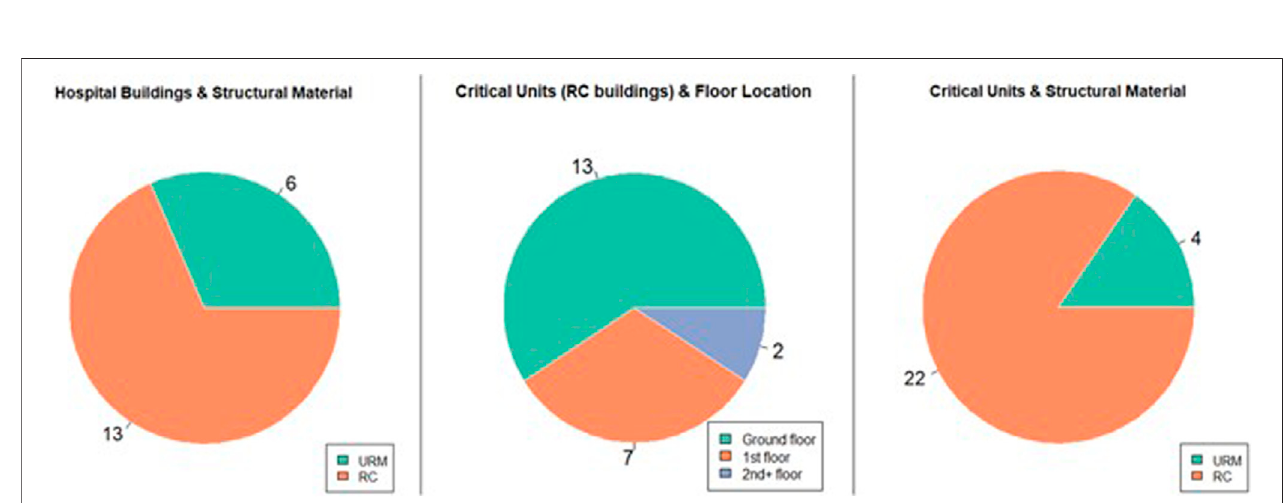
FIGURE 5 | Statistics of the hospital buildings and critical